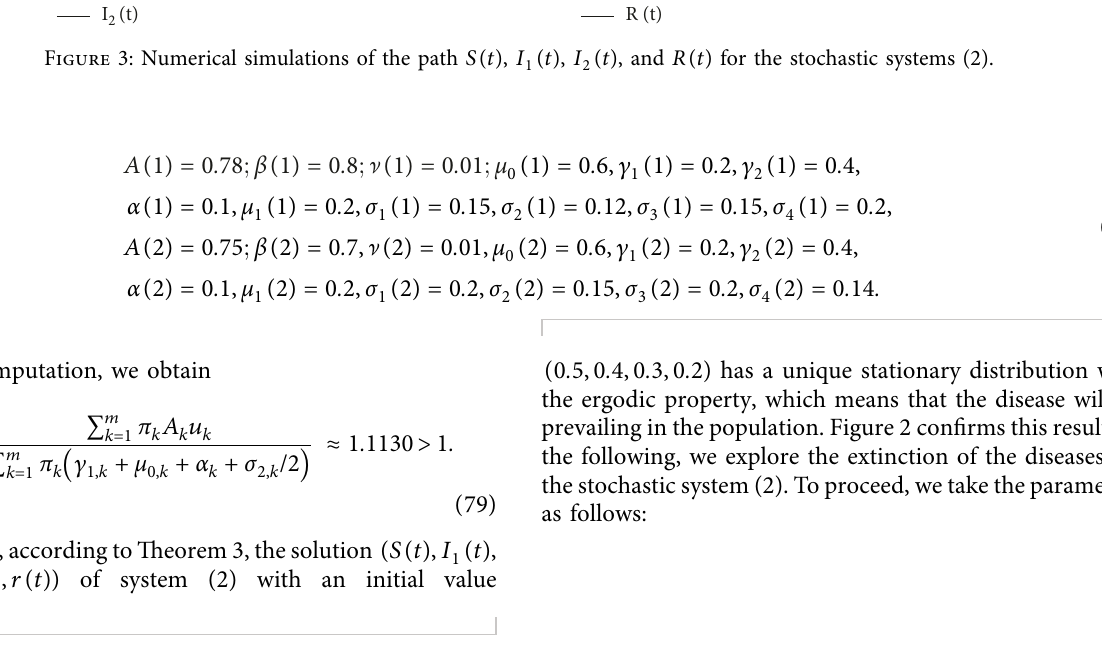
Figure 3: Numerical simulations of the path S ( t ) , I